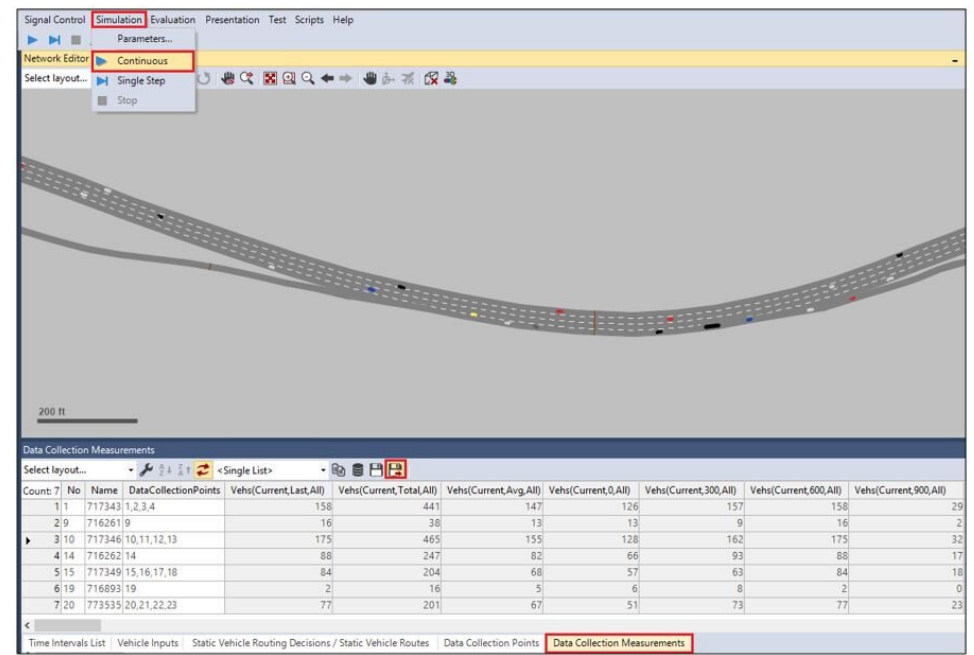
Figure 19. Presentation of a part of simulation experiment results in PTV Vissim.